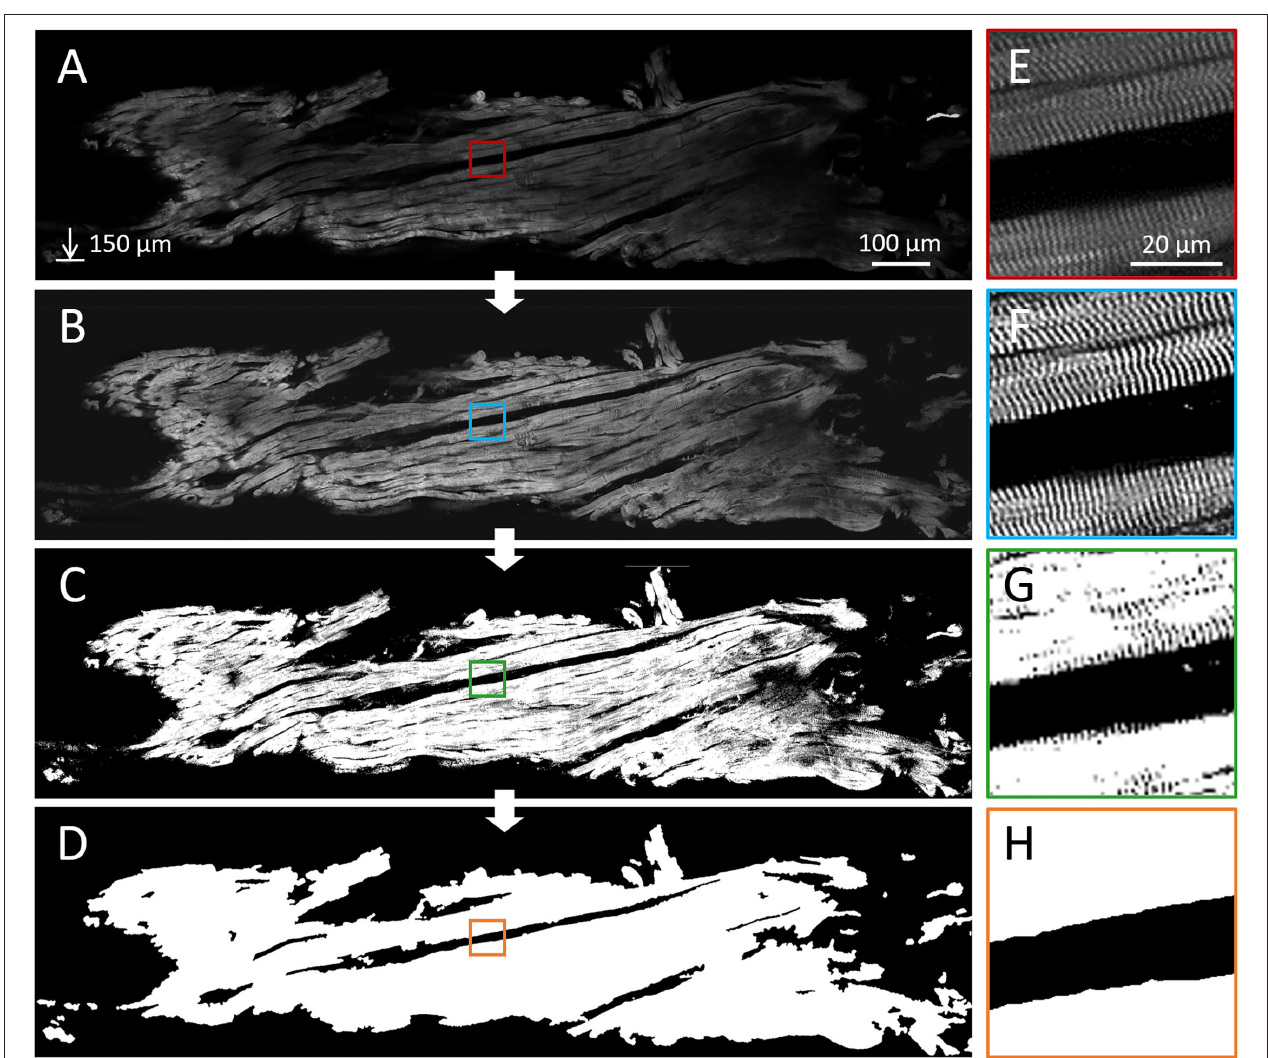
FIGURE 5 | Imaging and segmentation results. Reconstruction and segmentation of the contractile fibers in a human septal tissue strip, labeled with an anti- α -actinin antibody and imaged with a two-photon fluorescence microscope. (A) A representative sagittal plane of the reconstruction (Scale bar: 100 µ m, depth: 150 µ m, pixel size: 0.44 µ m). (E) Sarcomere Z-bands are visible in the whole strip at sub-micrometer resolution. Results of the main steps of the image processing pipeline are shown: deconvolution and equalization (B,F) , binarization by means of the pixel classification (C,G) , and the final tissue segmentation (D,H) obtained by smoothing the previous